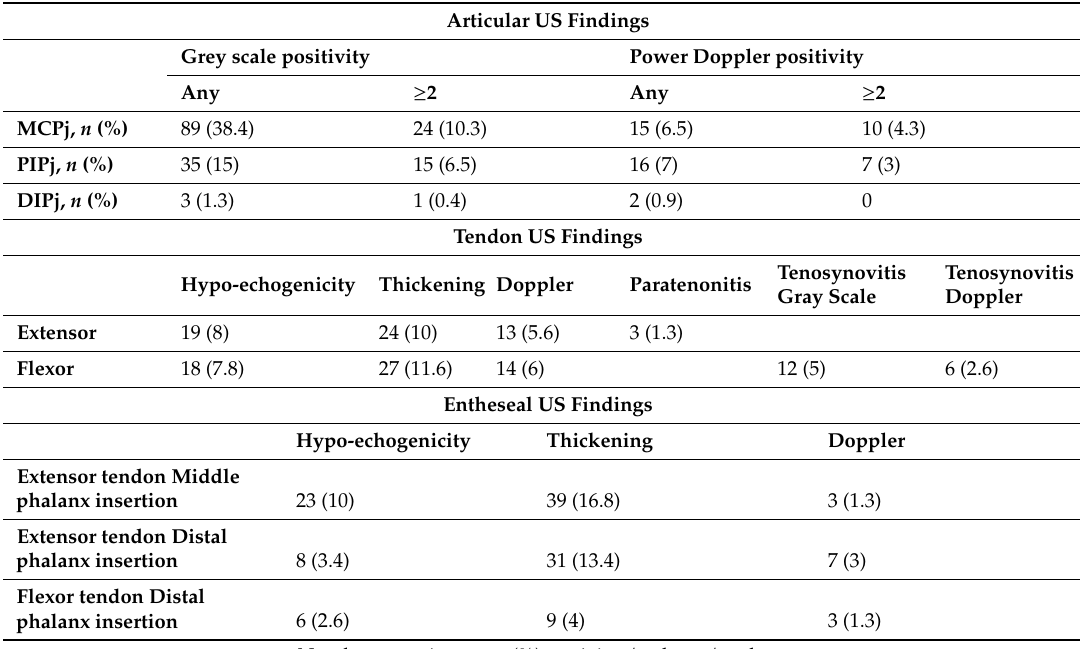
Table 2. Ultrasonography